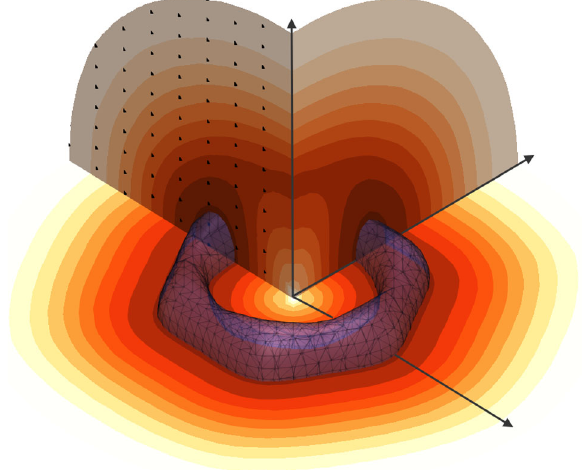
FIG. 1. Partial derivative of correlation energy with respect to the Coulomb kernel for graphite. Slices and isosurface of S ð G Þ for carbon graphite in the ABC stacking. Darker colors indicate more negative values. White corresponds to zero. The blue isosurface is a hexagonally shaped torus, and it reflects the anisotropic shape for S ð G Þ . Black dots represent the sampling points using a 4 × 4 × 4 k -point